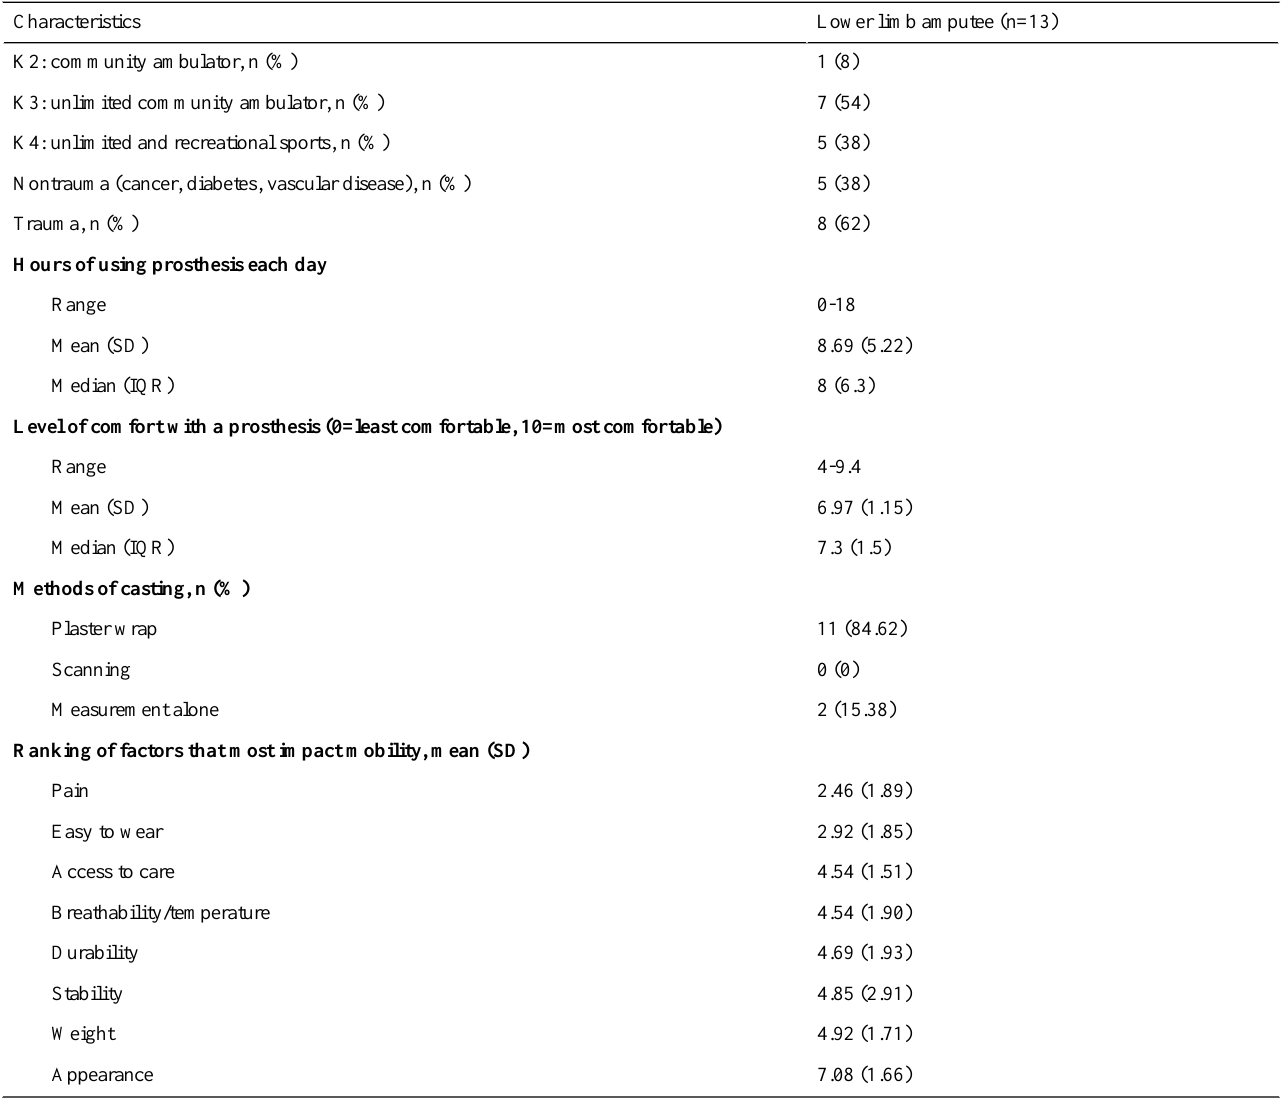
Table 2. Characteristics of lower limb